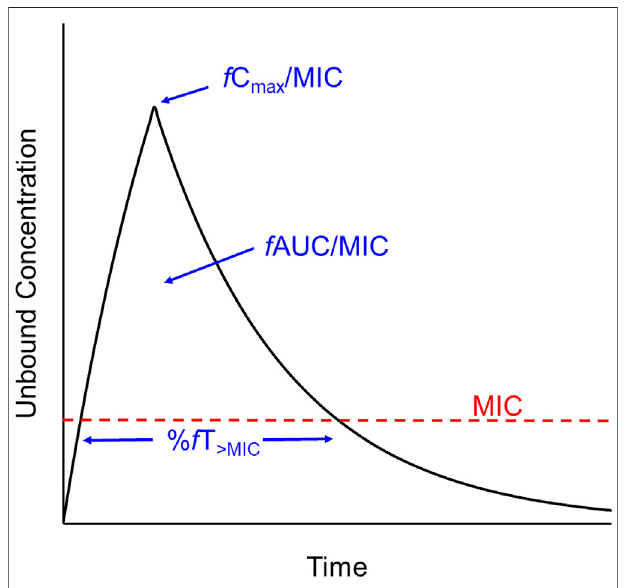
FIGURE 1 | Hypothetical concentration vs. time pro fi le of an antibiotic showing the three traditional, MIC-based PK-PD indices described in the text.